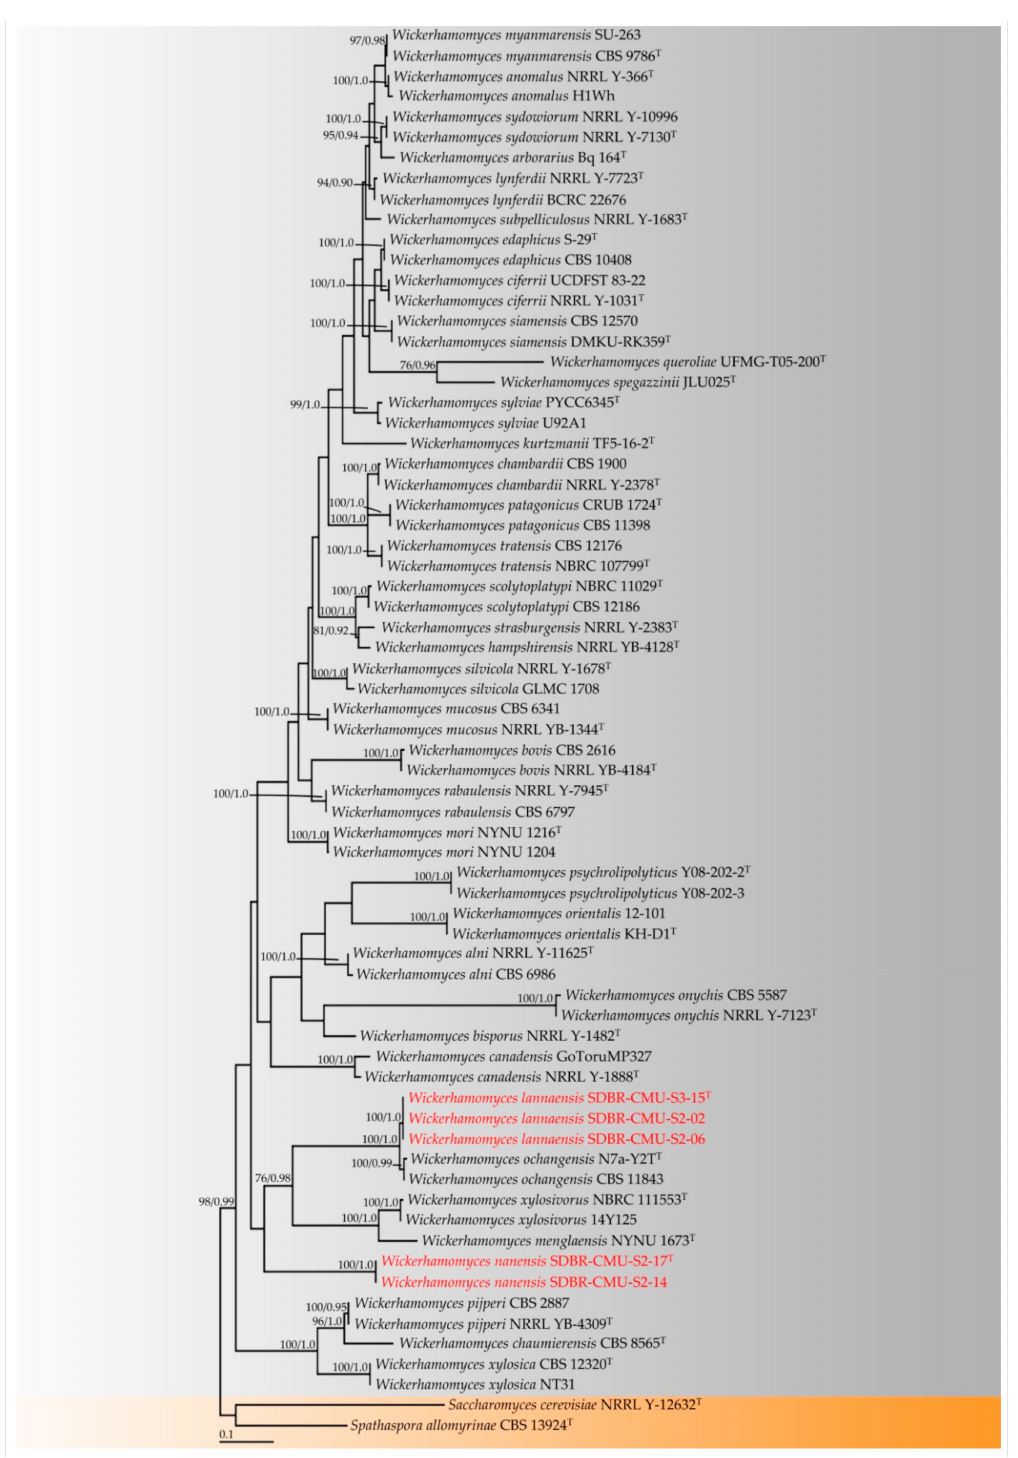
Figure 3. Phylogram derived from maximum likelihood analysis of 69 sequences of the combined ITS and D1/D2 sequences. Saccharomyces cerevisiae NRRL 12632 and Spathaspora allomyrinae CBS 13924 were used as the outgroup. The numbers above branches represent bootstrap percentages ( left ) and Bayesian posterior probabilities ( right ). Bootstrap values ≥ 75% and Bayesian posterior probabilities ≥ 0.90 are shown. Sequences obtained in this study are in red. Superscription “T” means the type